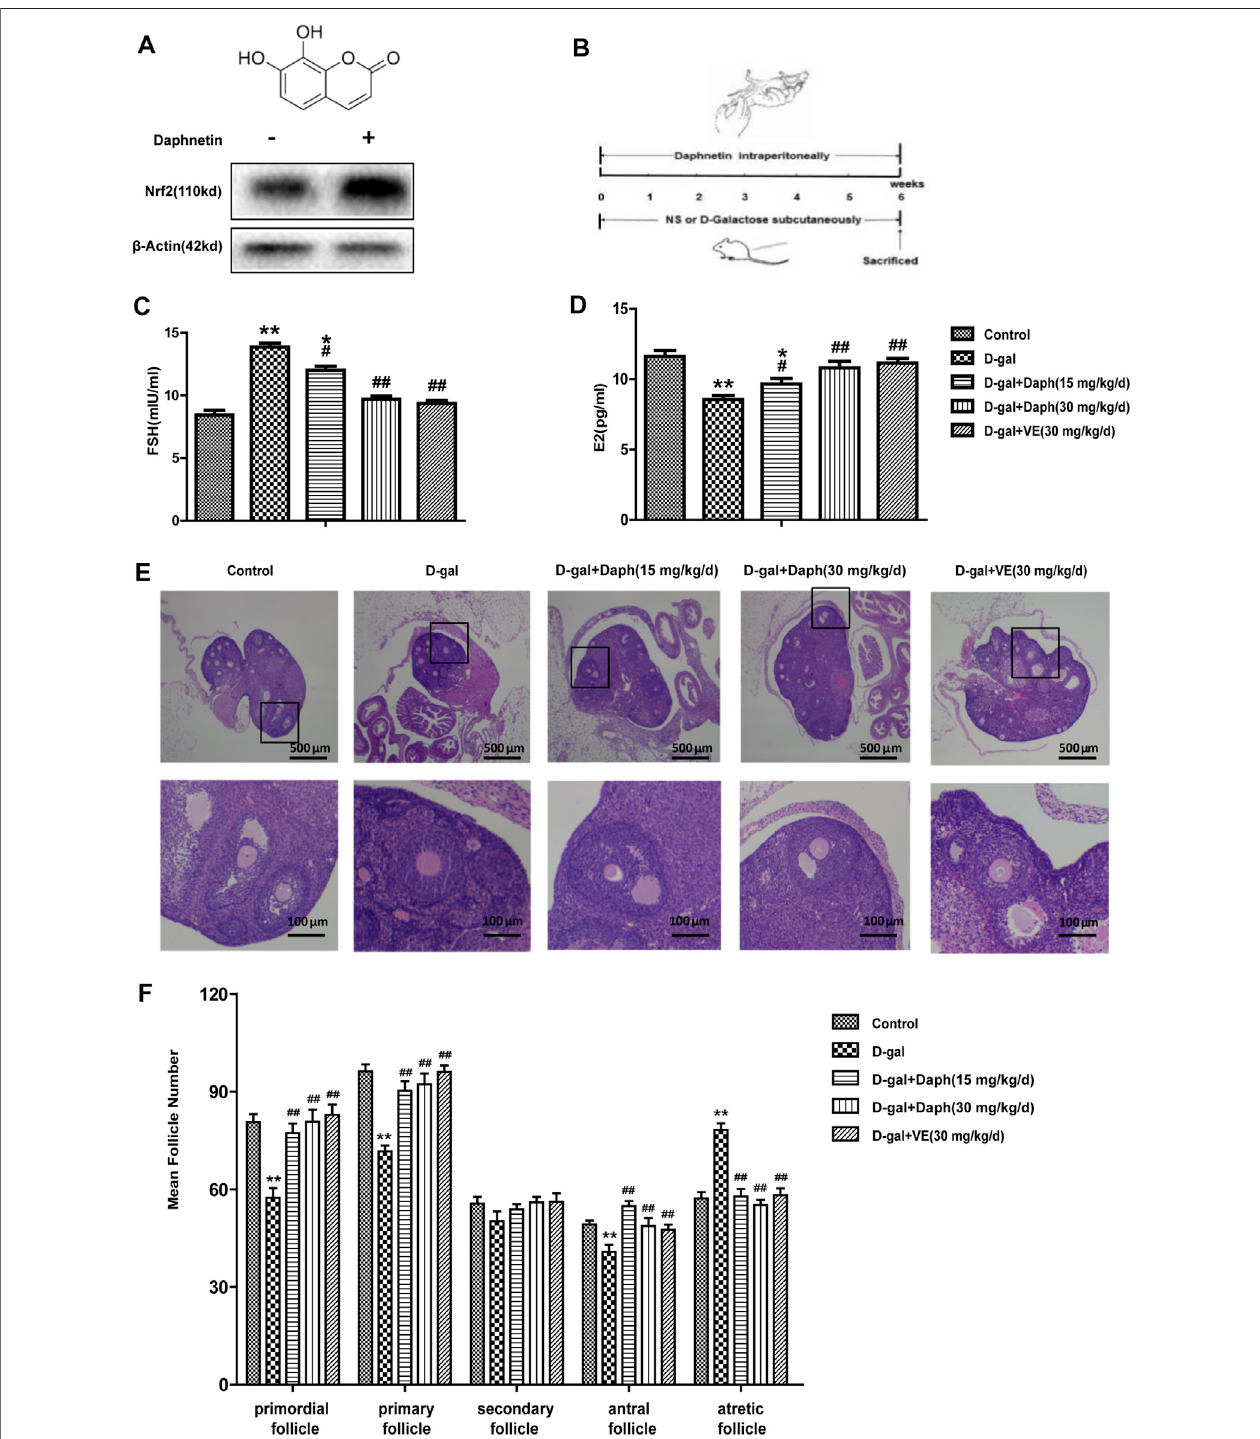
FIGURE3 | Protective effects of Daph on the ovarian function and follicular development. (A) The structure ofDaph monomer and immunoblottinganalysisof Nrf2 protein expression after Daph was administrated. (B) Construct mice model according to the method as shown. (C,D) Serum FSH and E2 were tested in the control, D-gal,DaphandVEgroups. (E,F) Folliclesin fi vegroupswereobservedafterH&Estainingandthenumbersoffolliclesatdifferentstagesofmaturationweresummarized. The data in C-F are shown as means ± SEMs, n = 5. The data in A are shown as means ± SEMs, n = 3. Statistical signi fi cance: * p < 0.05, ** p < 0.01, # p < 0.05, ## p <